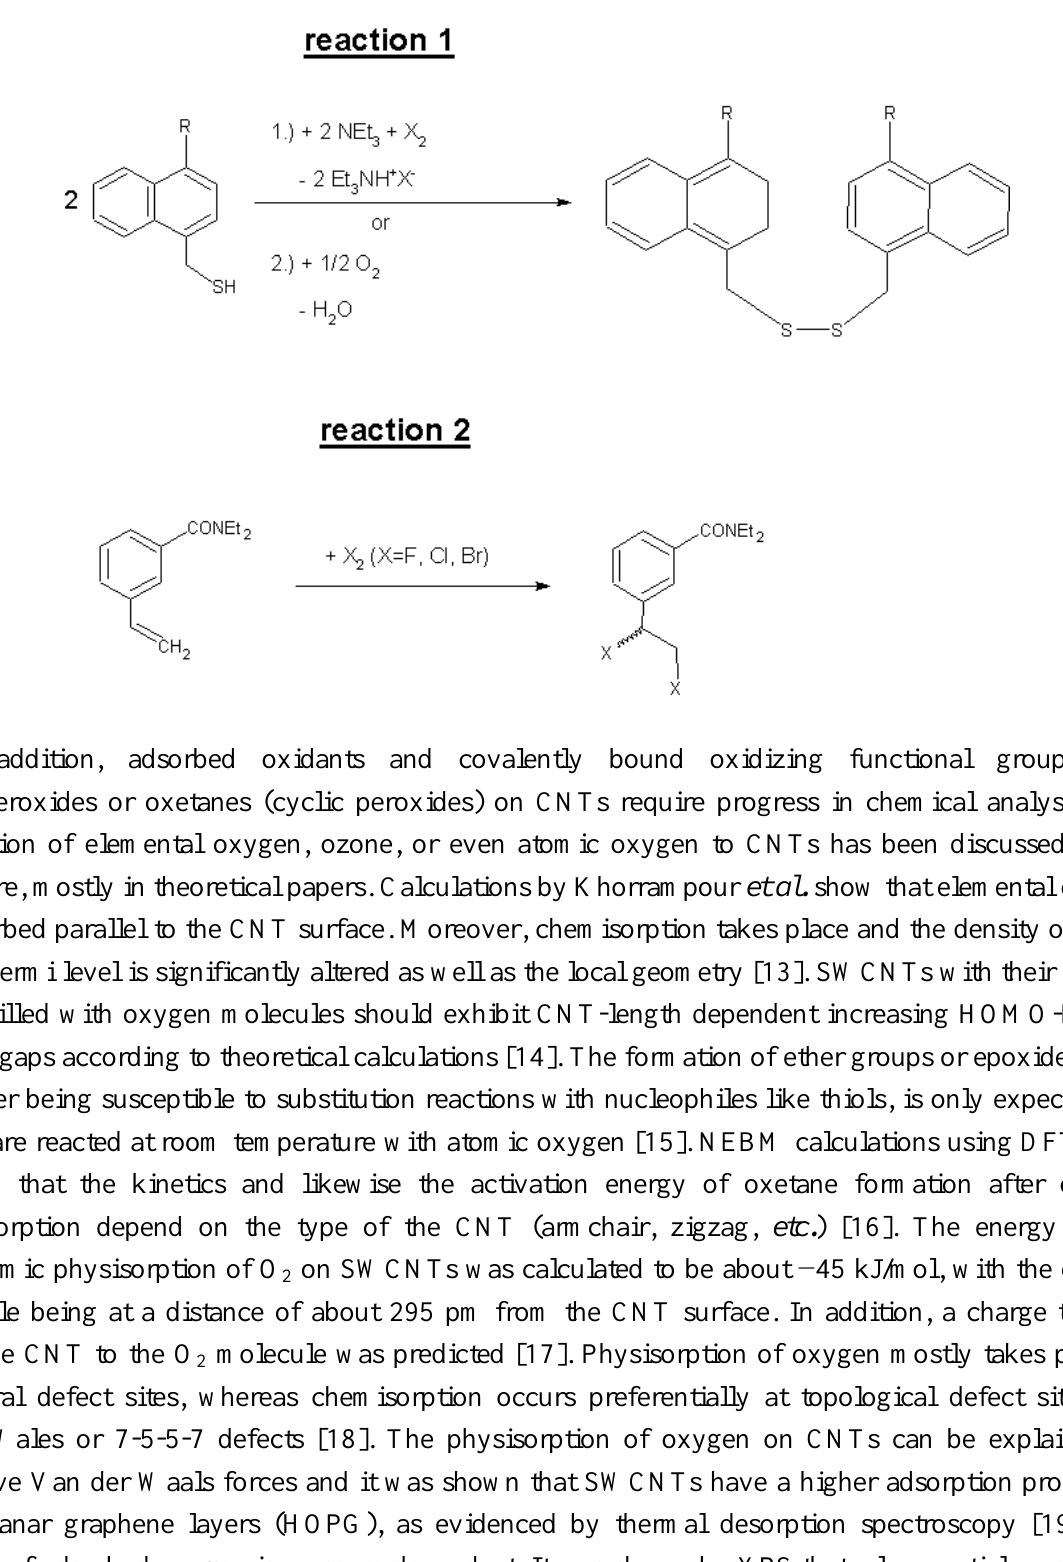
Figure 1. Reactions of substituted (R = organic monovalent rest) 1-naphthylmethylmercaptans with halogens or oxygen and of a substituted 3-styrenecarboxamide with halogens (all at room-temperature